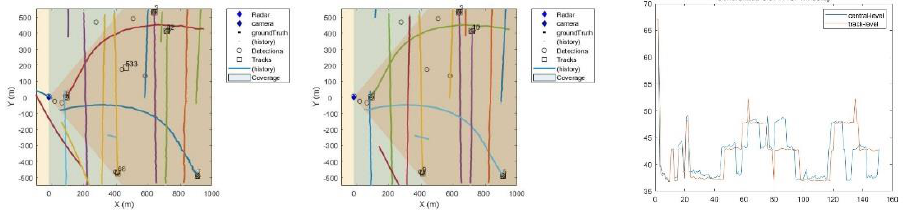
Fig. 5. Fusion without Track-quality selection of two structures. Left: central-level fusion. Centre: track-level fusion. Right: OSPA curve.